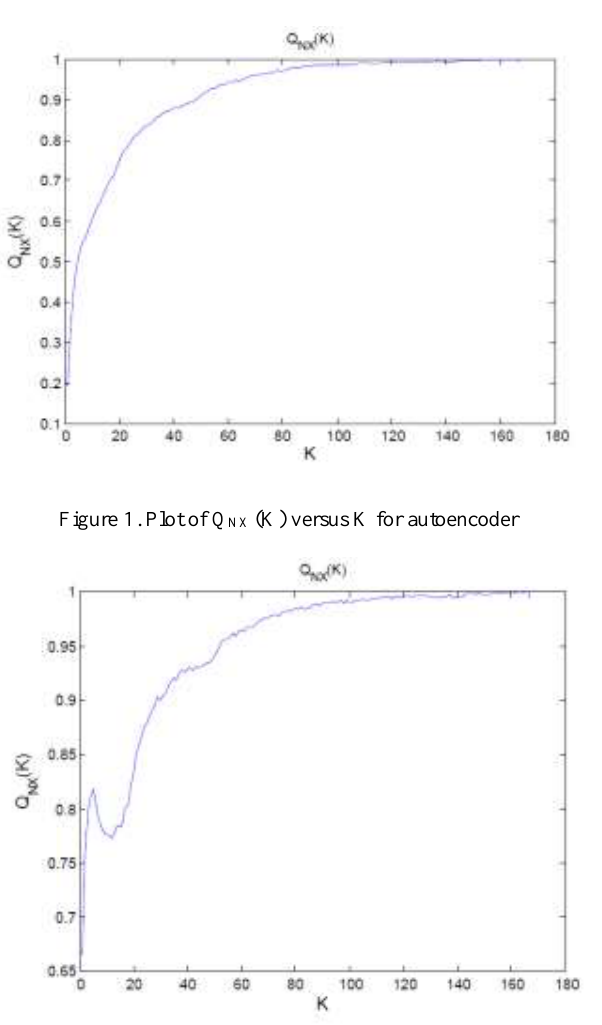
Figure 2. Plot of Q NX (K) versus K for deep autoencoder